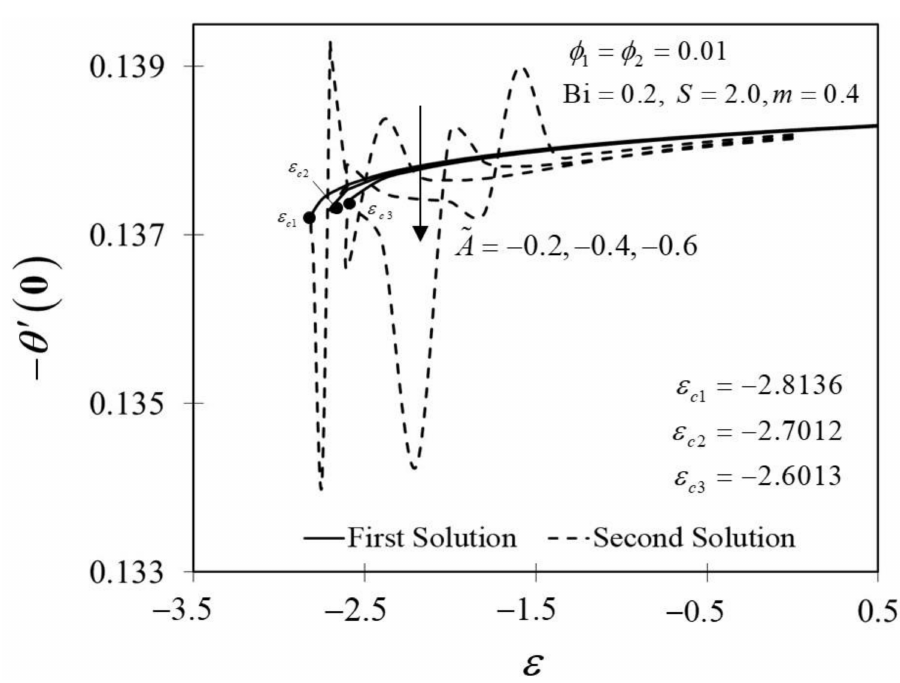
Figure 9. Trend of − θ (cid:48) ( 0 ) with ε and assorted A . The consequence of the suction parameter S with ε is presented in Figures 10 and 11. Figure 10 emphasizes that as S escalates, f (cid:48)(cid:48) ( 0 ) amplifies in the first solution of the